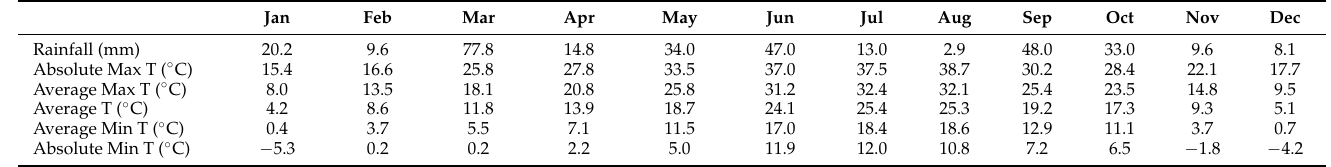
Table 1. Rainfall and temperatures at the producing site (El Soler à s, 41 ◦ 24 (cid:48) N; 0 ◦ 40 (cid:48) E) in